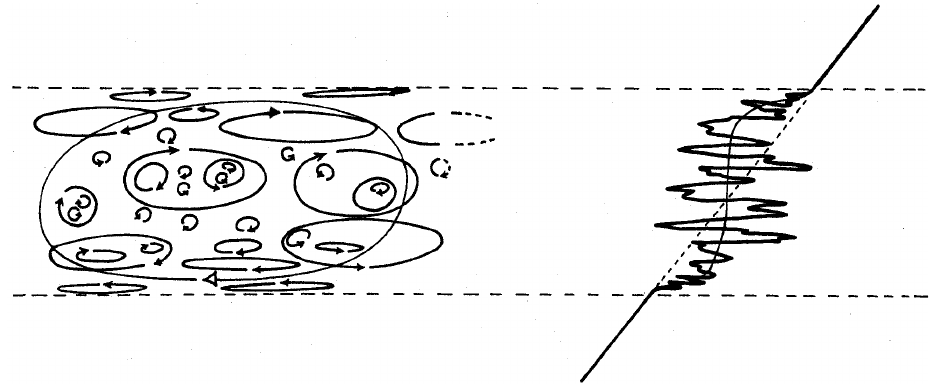
Fig. 9. Illustration from Woodman and Chu (1989) showing a proposal for the structure of radio-wave scatterers within a turbulent layer. More anisotropic scatterers are expected near the top and bottom of the layer. Several other similar proposals appear in various papers in the literature (see text for details).